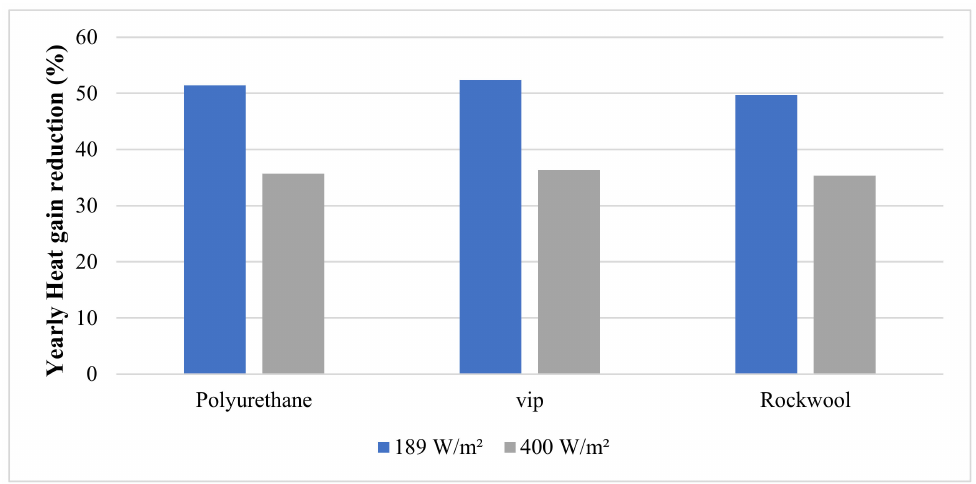
Figure 8. Yearly reduction in the heat gain of the building applying different types of window glass integrating three types of window shutters’ insulations for different solar intensities.